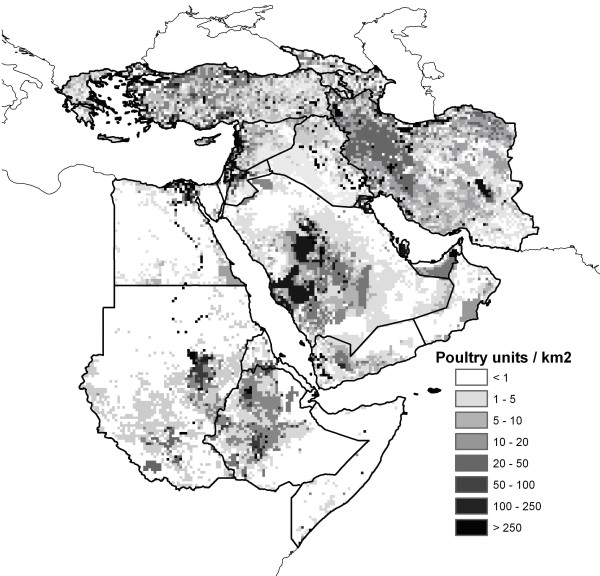
Density of poultry in the Middle East and northeastern Africa (units per km2) [13].